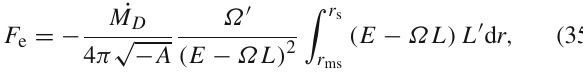
Fig. 13 The complete apparent images of the Schwarzschild BH with mass 1 . 732 × 10 6 M (cid:9) and the Schwarzschild-MOG BH with mass 10 6 M (cid:9) and α = 0 . 9. Here, the observational angle and BH distance are